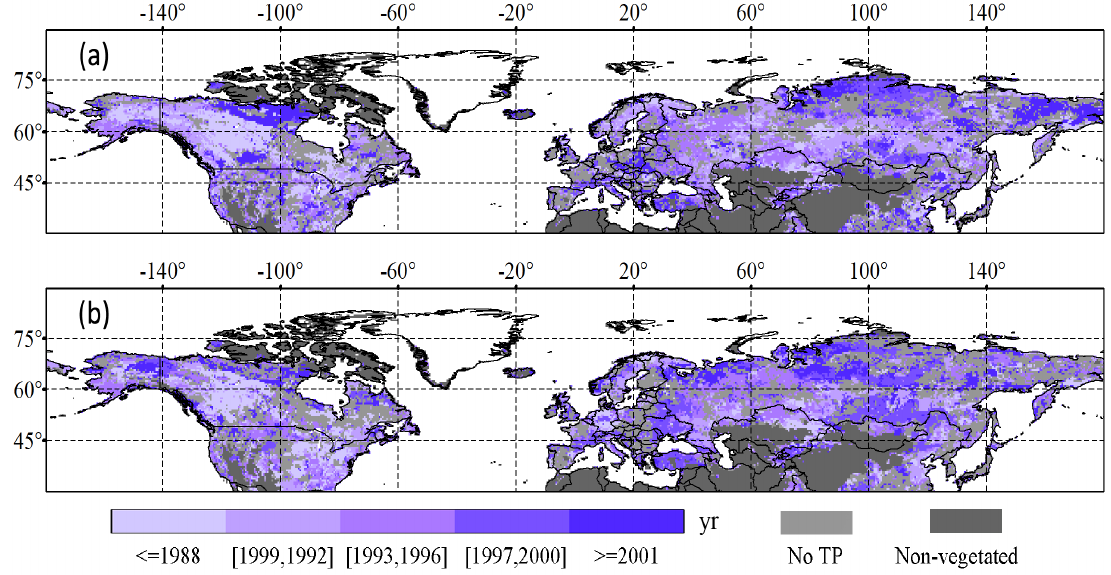
Figure 5. Timing of turning point (TP) in the growing-season NDVI time series detected from ( a ) NDVIg and ( b ) NDVI3g during 1982–2008.